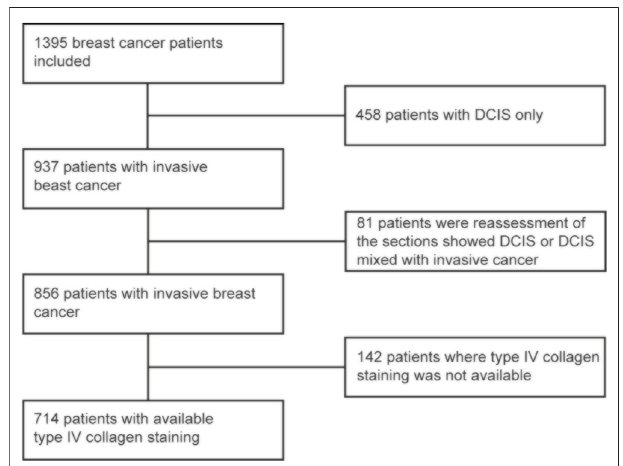
FIGURE 1 | Flow chart for selection of the patients for the fi nal study